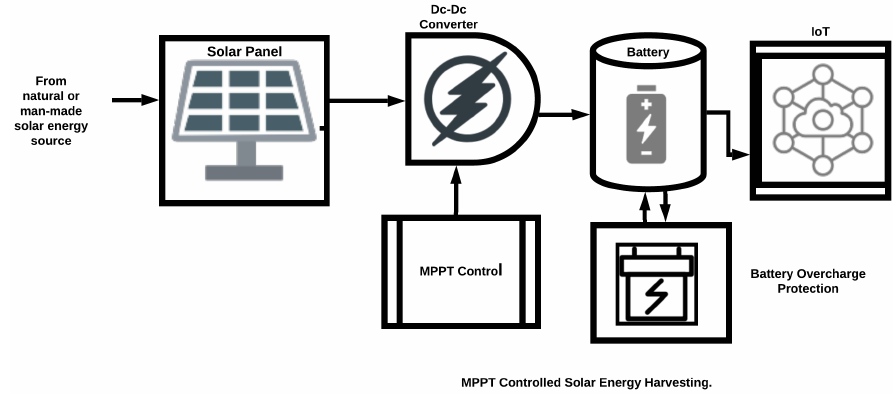
Figure 11. Maximum power point tracking (MPPT) Controlled Solar Energy Harvesting.